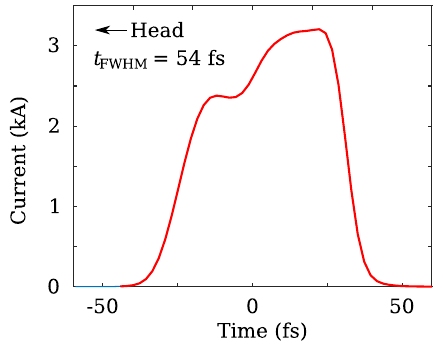
FIG. 6. The bunch distribution as obtained by the transverse cavity, XTCAV. The head of the bunch is to the